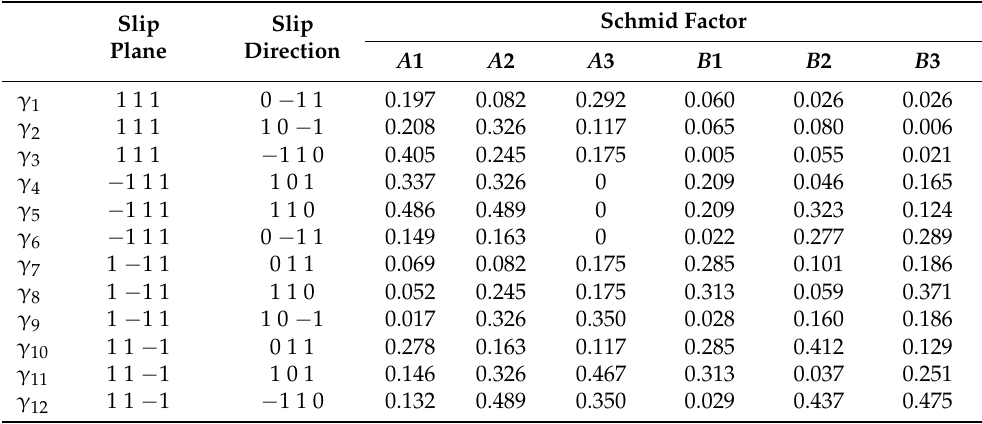
Table 2. Definition of the slip systems used in the crystal plasticity model and the Schmid factors of the slip system for the three